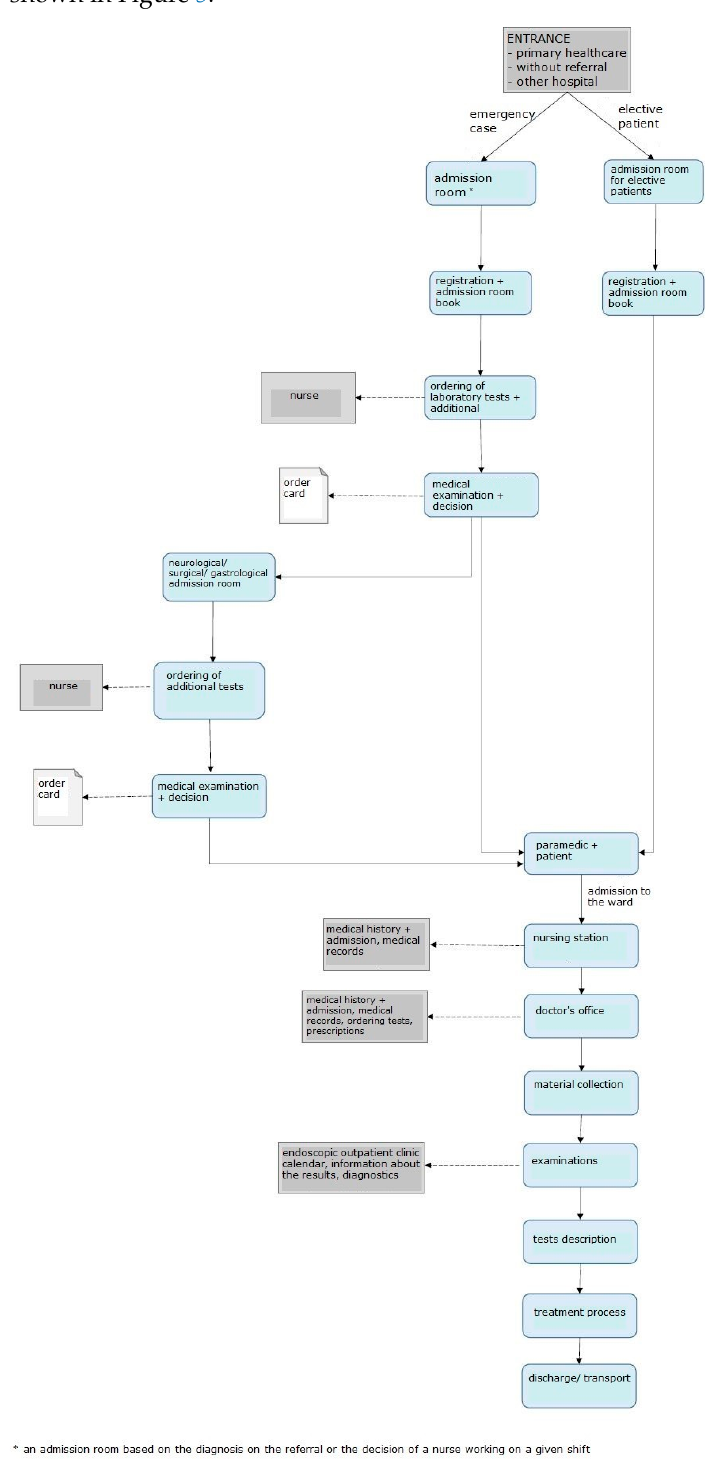
Figure 4. Diagram showing the process of admitting and treating a patient before the introduction of LM. Source: Own